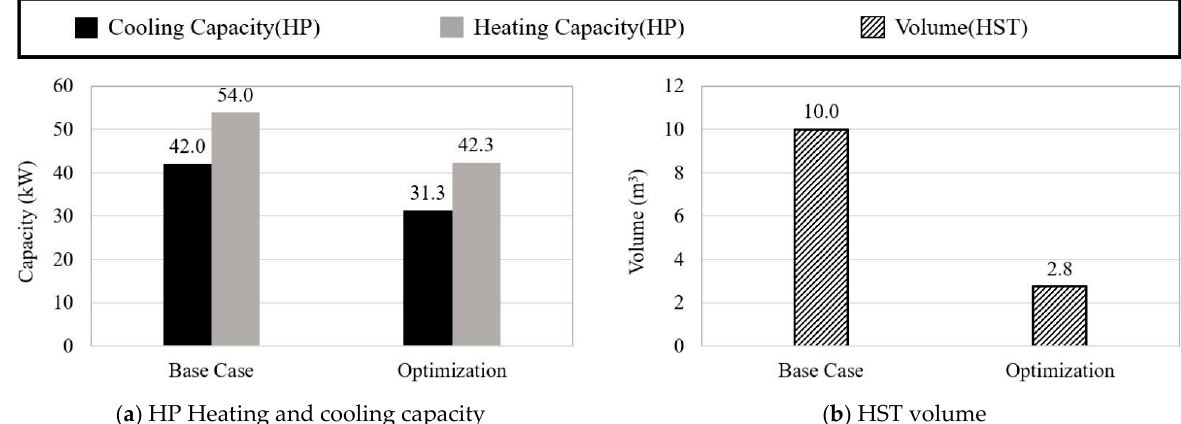
Figure 9. Comparison of optimization results; ( a ) comparison result between the existing design method and the optimized design method for the heating and cooling capacity of heat pumps, ( b ) comparison result between the existing design method and the optimized design method for the volume of the heat storage tank Figure 11. Result of economic analysis; ( a ) comparison of economic feasibility between the existing design method and the optimized design method for initial investment cost, energy cost, and total cost. ( b ) LCC comparison analysis result between the existing design method and the optimized design method